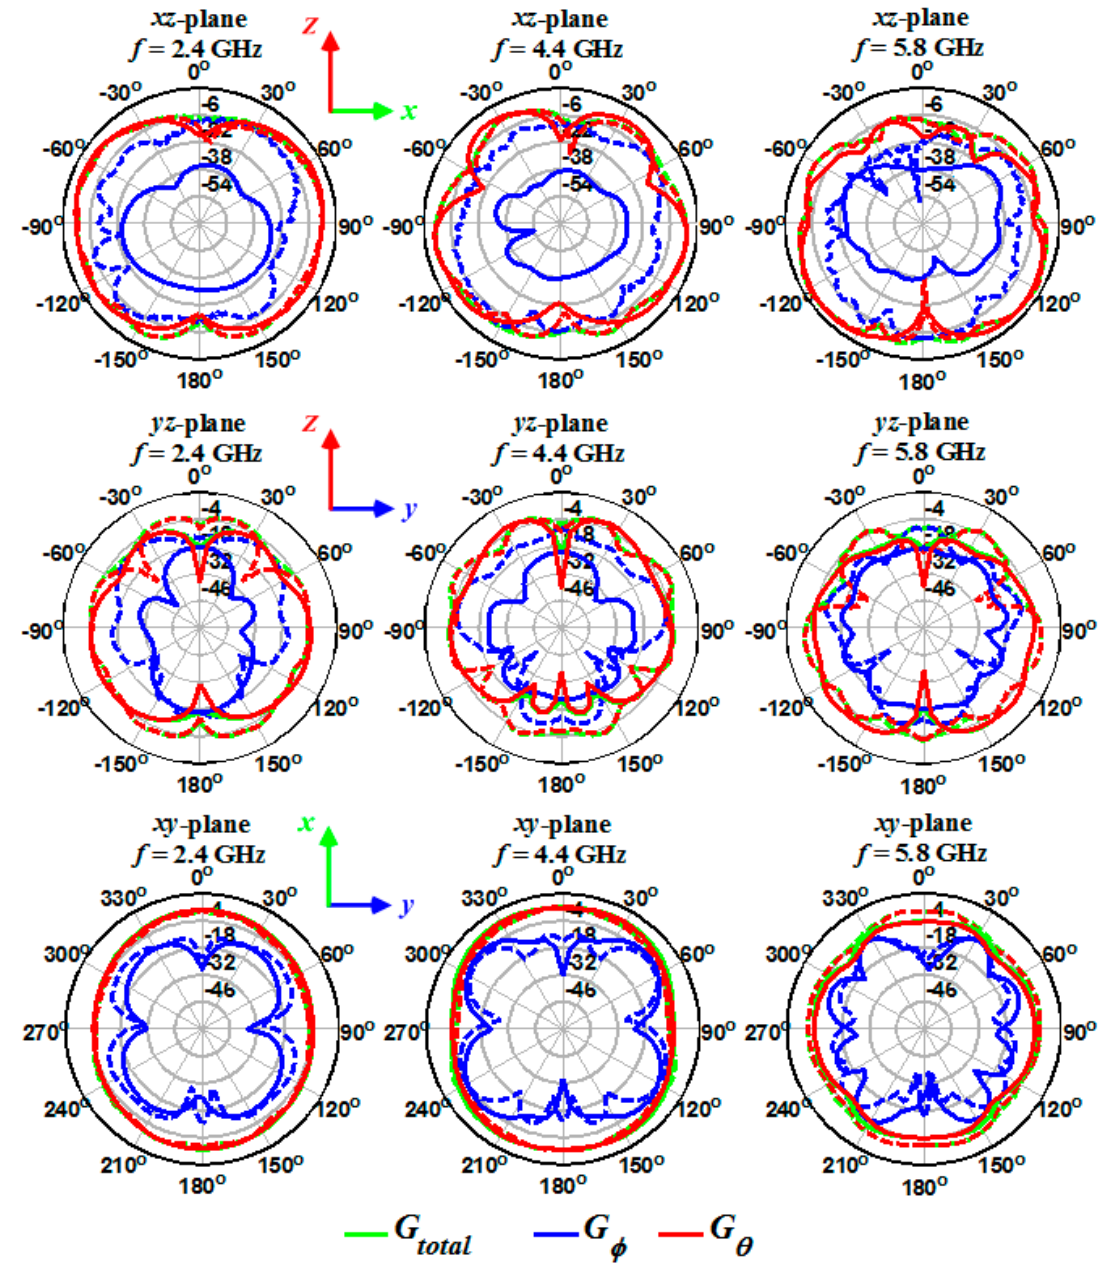
Figure 21. Measured (dashed lines) and simulated (solid lines) gain for the four-port antenna on three different planes and frequencies.